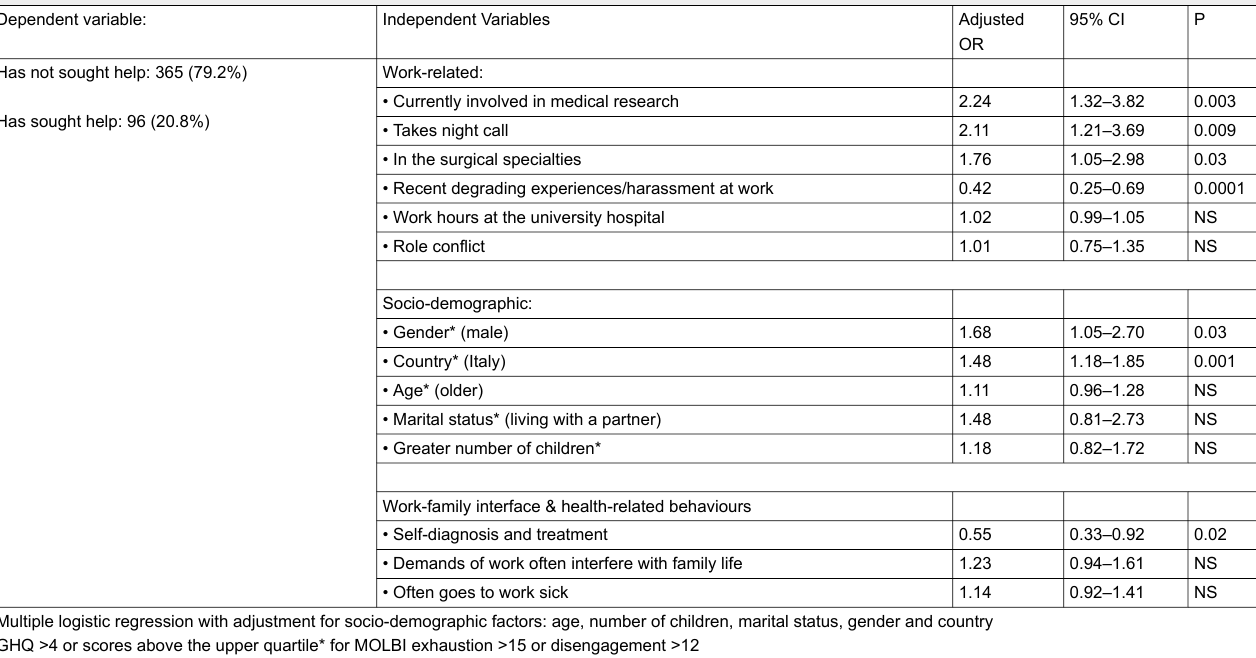
Table 3: Physicians with GHQ >4 or MOLBI exhaustion scores >15* or MOLBI disengagement >12* in the HOUPE study: Significant adjusted odds ratios for not having sought help for burnout or depression. Dependent